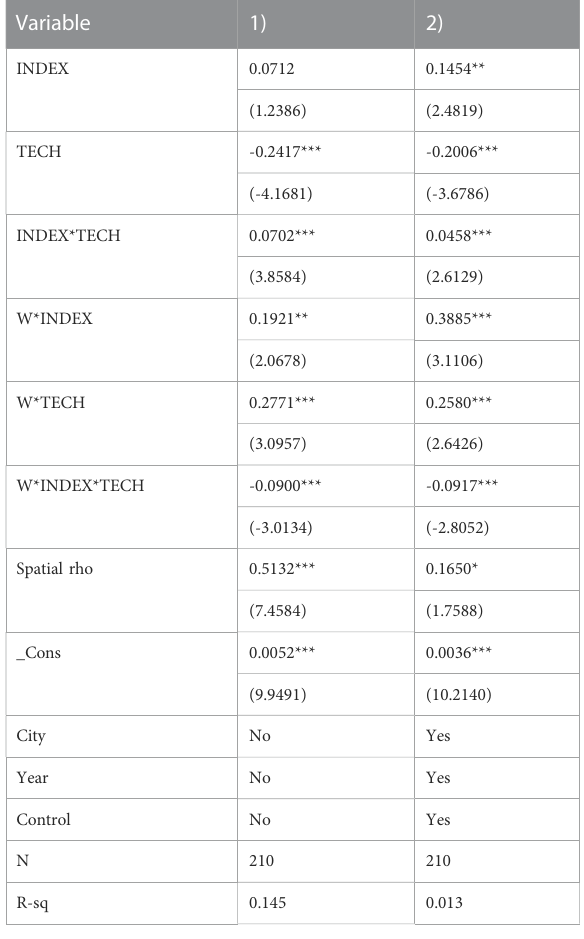
TABLE 7 Spatial Durbin model regression for technological innovation. Variable